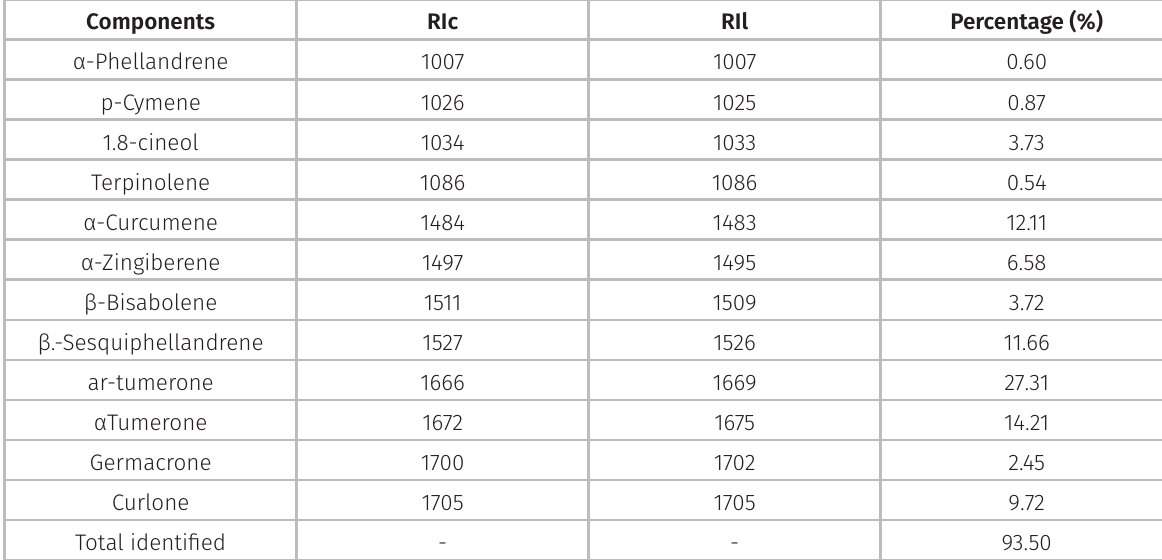
Table I. Volatile profile of Curcuma longa hydrolate.